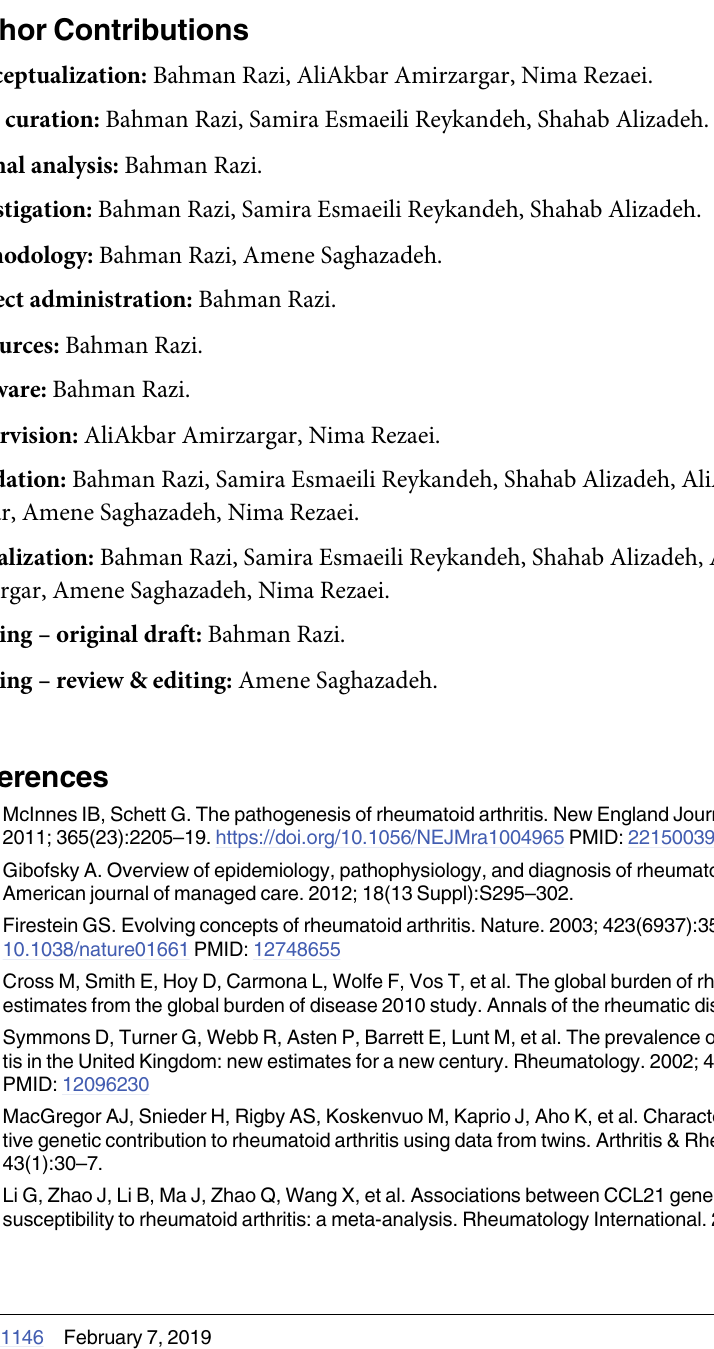
S3 Fig. Funnel plot for TIM3 rs10515746. (TIFF) S4 Fig. Funnel plot for TIM4